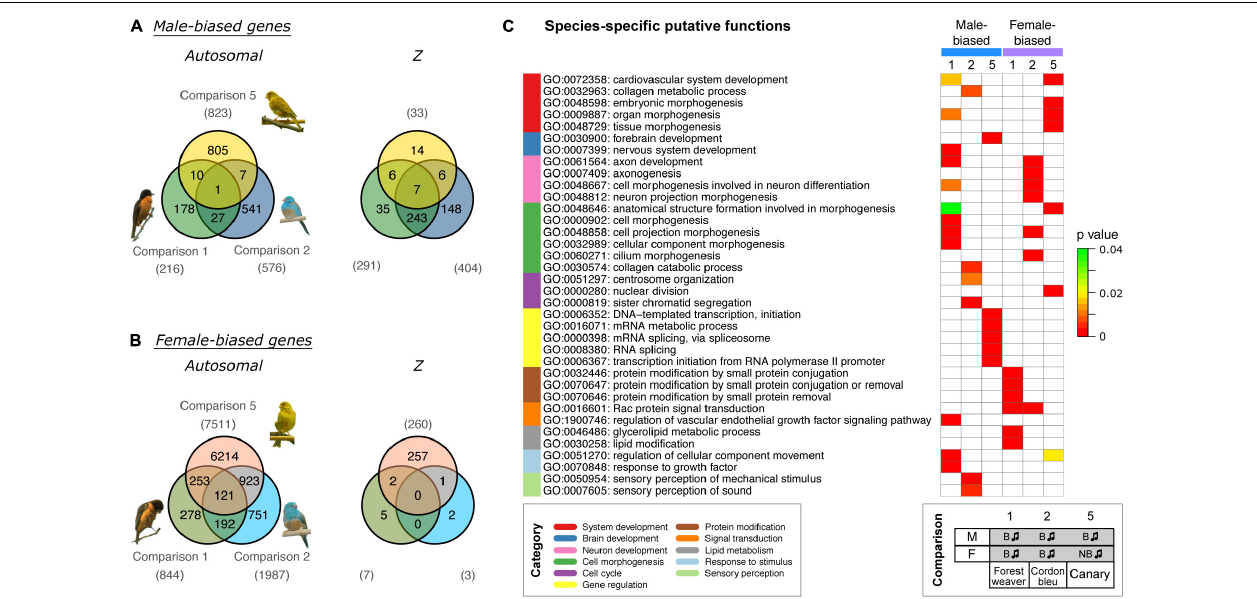
FIGURE 3 | Cross-species comparisons of sex-biased genes expressed in the HVC of birds with singing phenotypes shows high species specificity. Venn diagrams of male-biased (A) and female-biased (B) autosomal and Z chromosomal genes. The numbers of sex-biased genes are indicated in parentheses. (C) GO term enrichment analysis predicting the biological functions of sex-biased (autosomal and Z chromosomal) genes. The GO terms were categorised and are colour coded. Bonferroni-adjusted P -values are shown by colour scales in the heatmap. Only five GO terms with the lowest Bonferroni-adjusted P -values are shown for each set (see Supplementary Table 2 for the complete results). The phenotypes of the groups used for comparisons 1, 2, and 5 are listed at the bottom. B, breeding; NB, non-breeding. The music note indicates the presence or absence of singing behaviour.